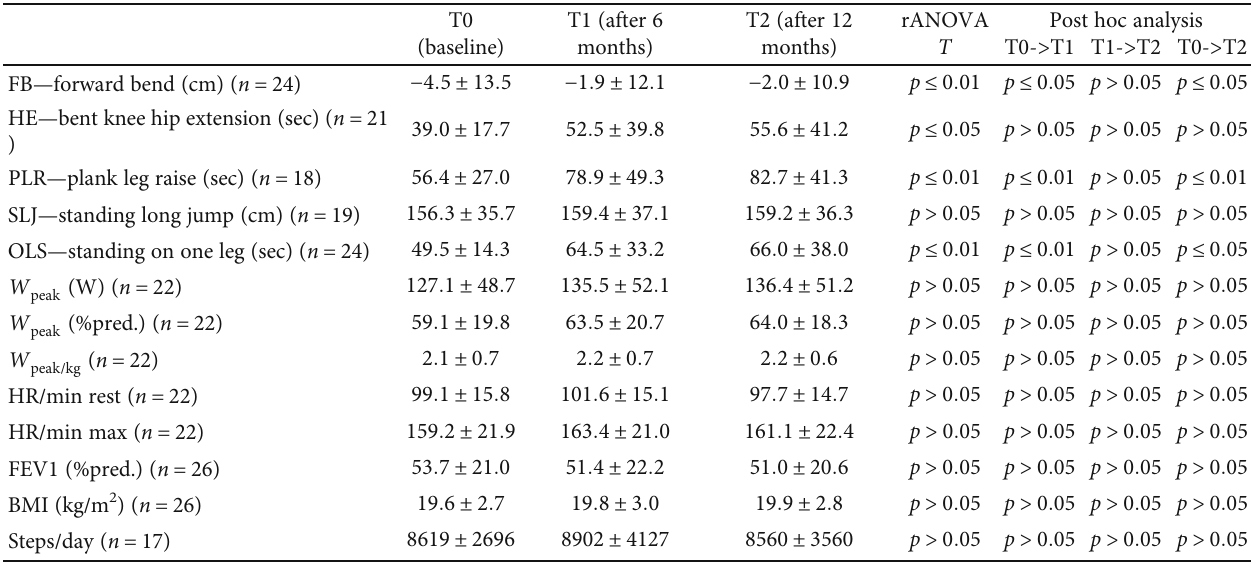
: peak work load (watts); FEV1: forced expiratory peak